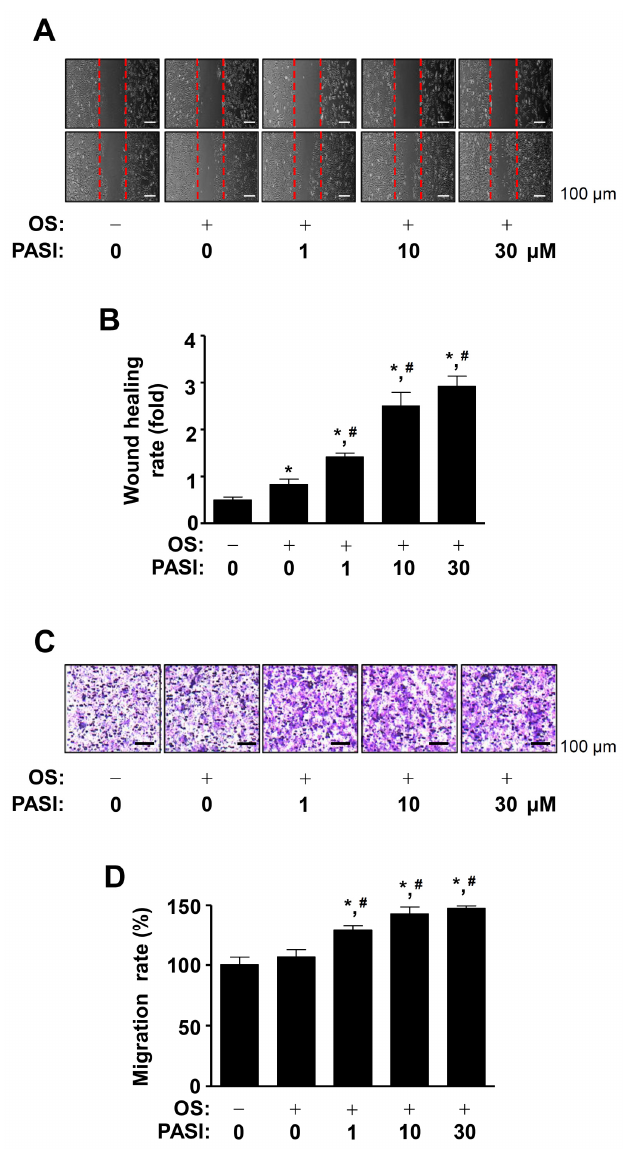
Figure 2. Effects of PASI on migration during osteoblast differentiation. ( A , B ) The wound healing rate (fold) was detected under a light microscope ( A ) and exhibited as a bar graph ( B ). ( C , D ) The Boyden chamber assay was carried out. The migration rate (%) was detected under a light microscope ( C ) and exhibited as a bar graph ( D ). Data are expressed as the mean ± S.E.M. of experiments. * p < 0.05, # p < 0.05 indicate a statistically significant difference compared to the control and OS,